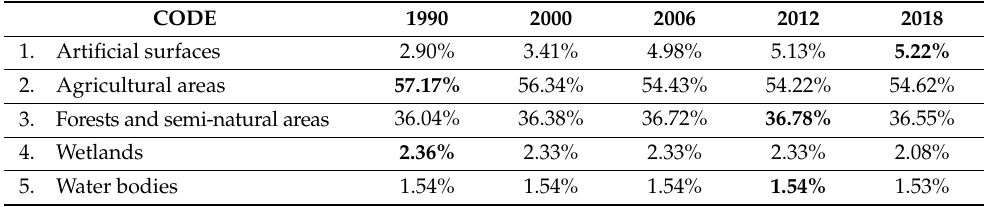
Table 2. Percentage of land-uses according to level 1 of CLC nomenclature in the Autonomous Region of the